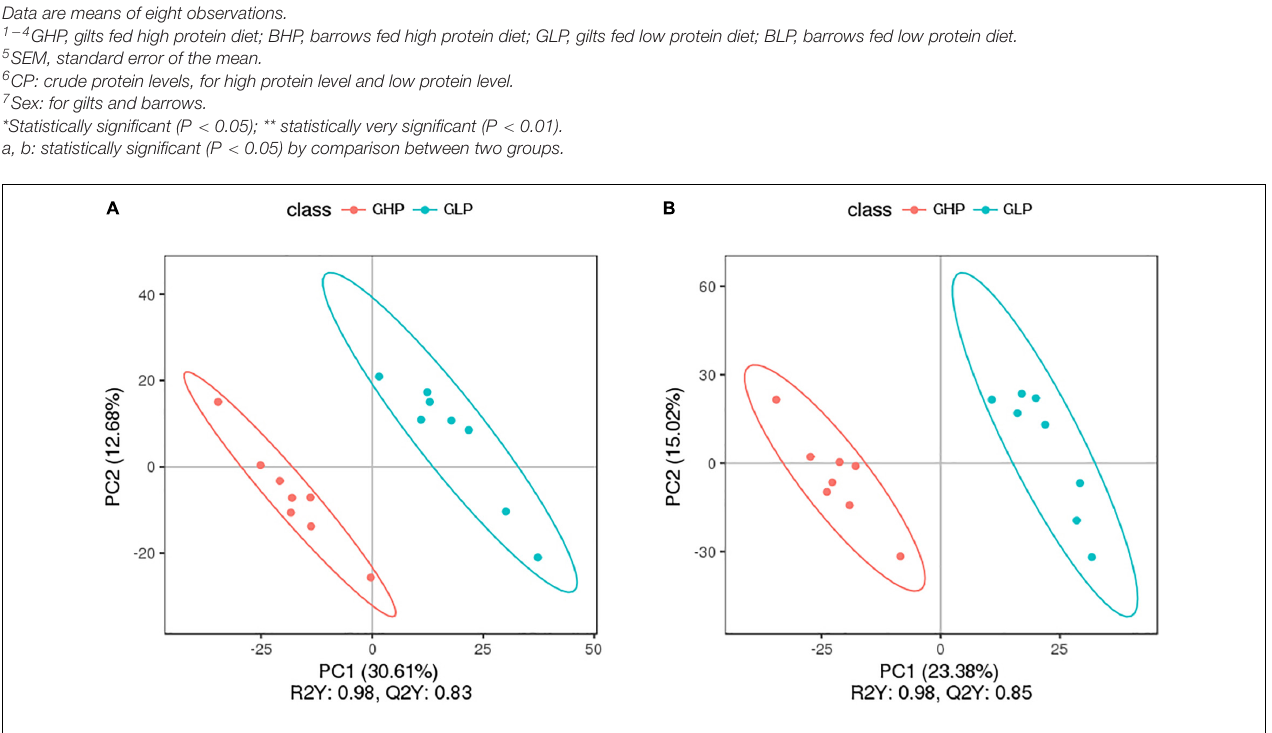
FIGURE 4 | PLS-DA score plot of colonic metabolomic data from gilts fed low and high protein diets. (A) LC-MS (ESI-); (B) LC-MS (ESI+). GHP, gilts fed high protein diet;GLP, gilts fed low protein